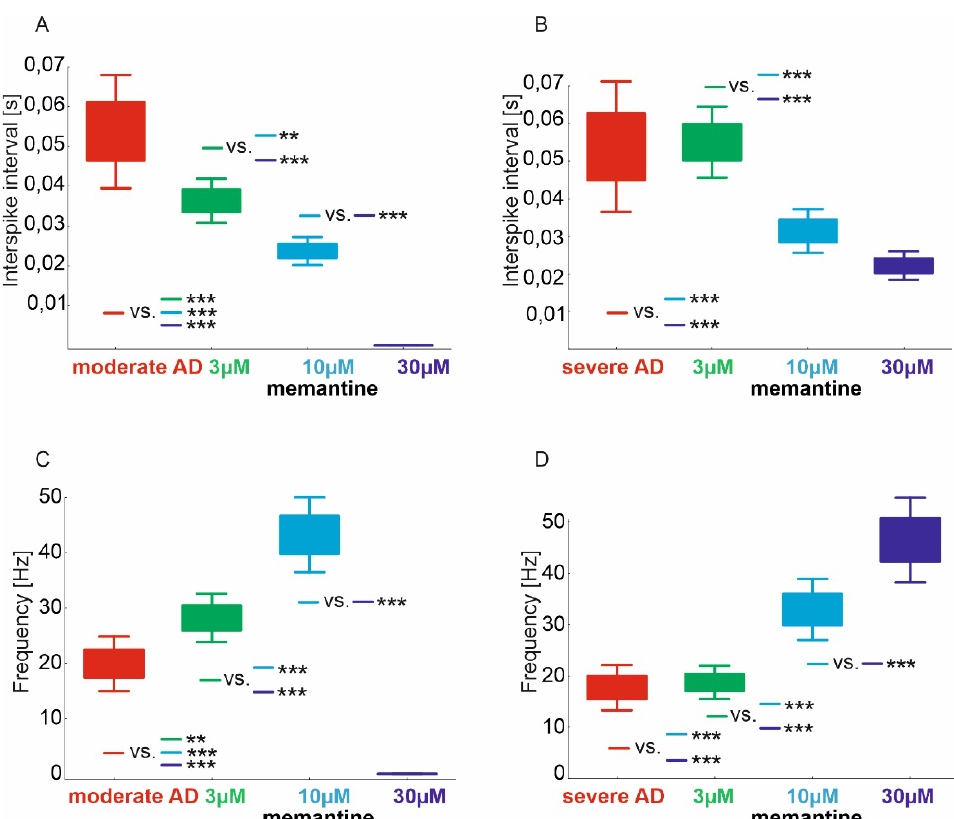
Figure 2. Comparison of ISI and frequency in virtual therapy of memantine treatment at three concentrations: 3 µ M, 10 µ M and 30 µ M of CA1 region. ( A ) ISI of moderate AD, ( B ) ISI of severe AD, ( C ) frequency of moderate AD, ( D ) frequency of severe AD (** p < 0.01, *** p < 0.001).